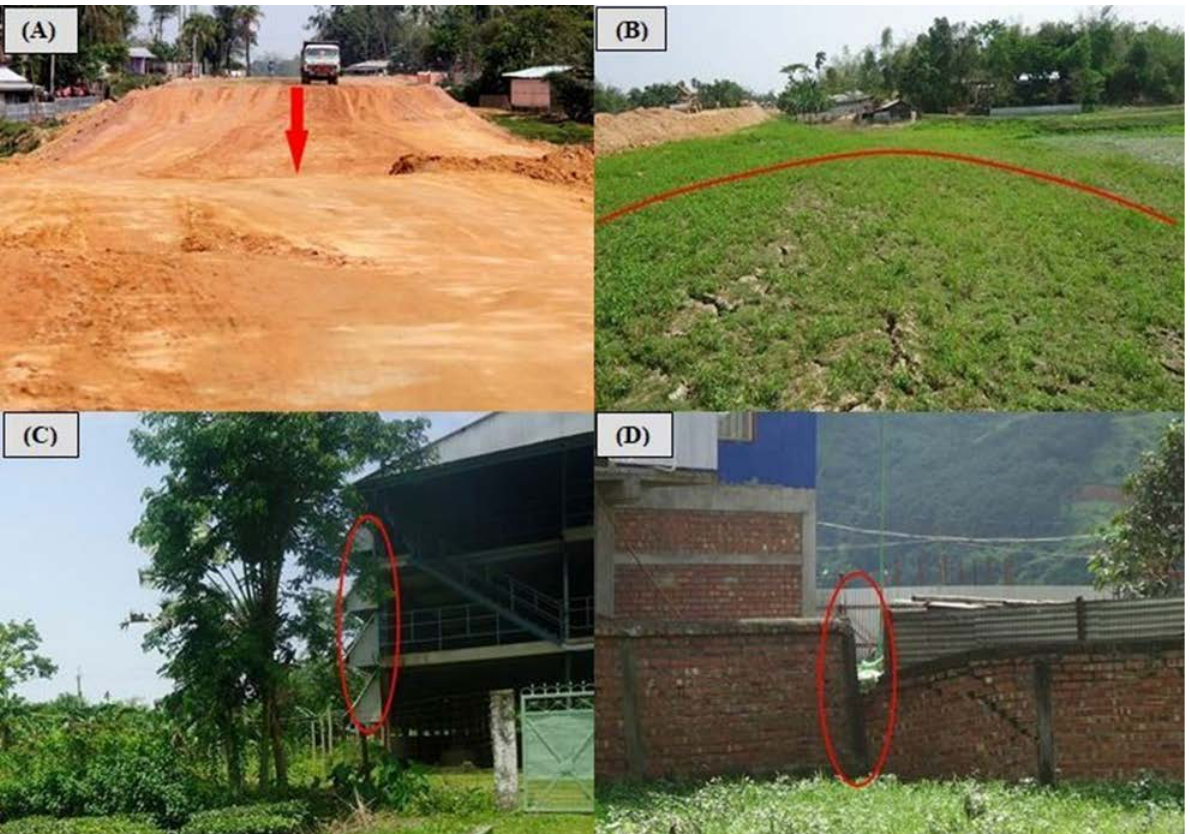
Figure 1. (A) and (B): embankment subsidence followed by heaving and shrinkage of adjacent ground at National Highway 39 (NH39); (C): a tilting building on peat at Kalinagar Tea Estate (KTE); (D): an existing structure sinking into the soil near the campus of National Institute of Technology, Manipur